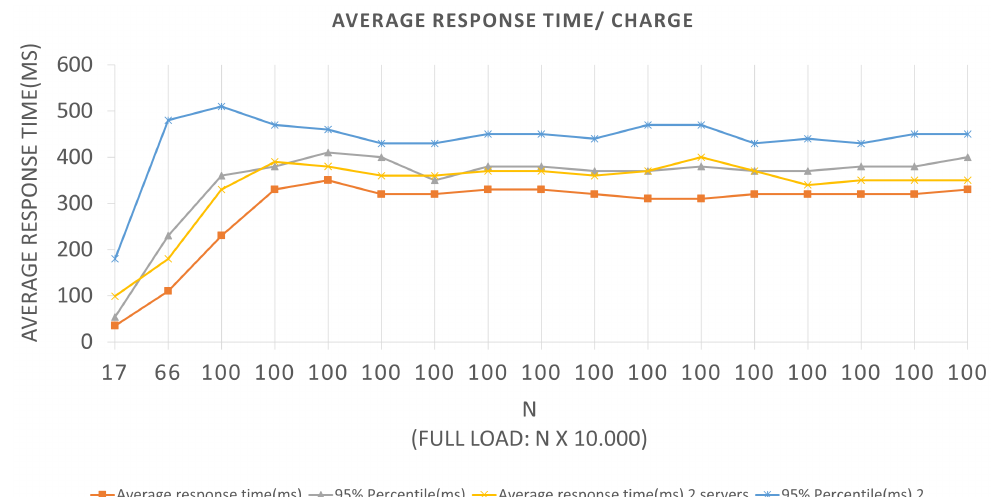
Figure 9. Results of the experiments for query loads.